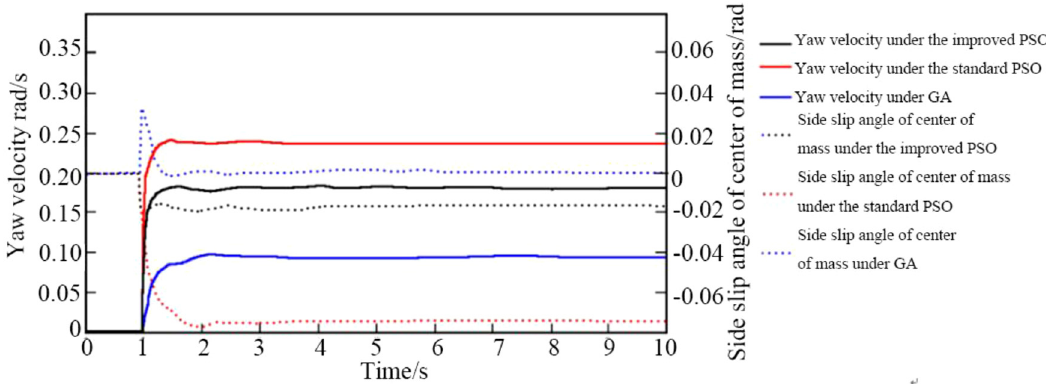
Fig. 6. The yaw velocity and sideslip angle of the center of mass of the forklift at a low driving speed under three